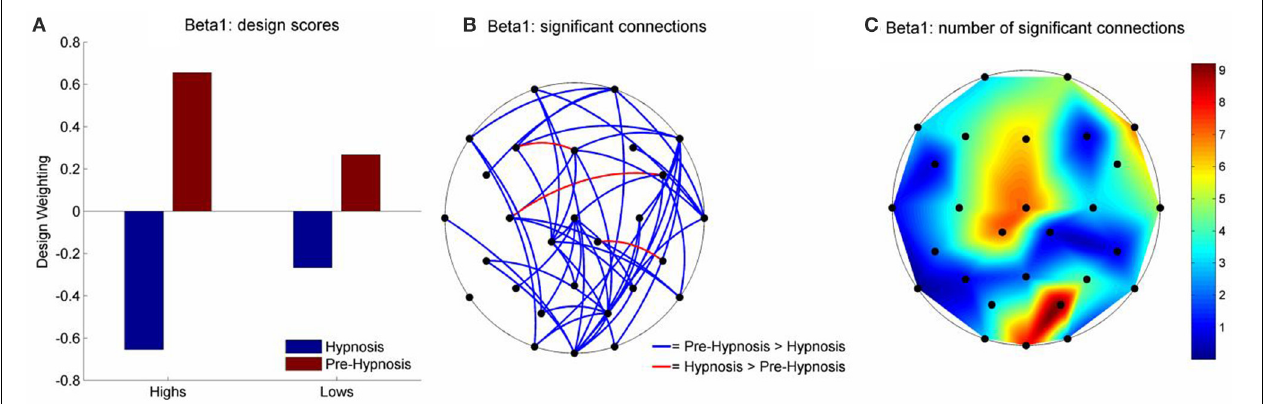
FIGURE 3 | Schematic Representation of the change in iCOH between the pre-hypnosisandhypnosisstatesinBeta1.(A) ShowstheDesignScoresfor thesignificantLVwhichwasacontrastbetweenthepre-hypnosisandhypnosis states. The loadings were greater for the high susceptible than for the low susceptible participants but the relative difference was less strong than was seen in Theta ( Figure 2A ). (B) Shows those connections that significantly loaded on the LV, red lines showing a positive loading and blue lines showing a